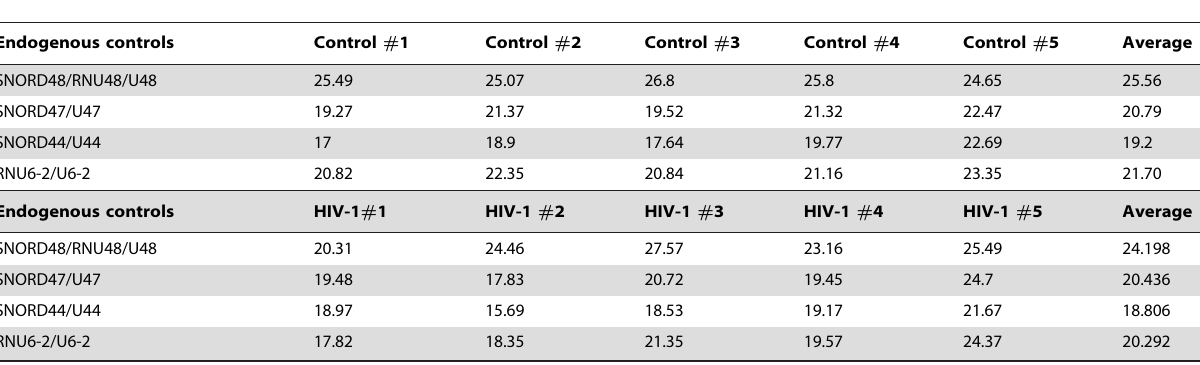
Table 1. Selected endogenous controls and their Ct